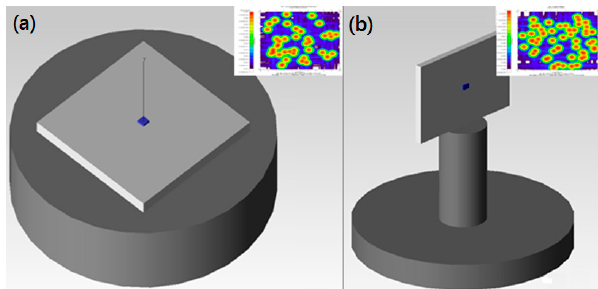
Figure 1. Traditional style of flip chip light ‐ emitting diode (FCLED) on non ‐ transparent submounts ( a ), and proposed transparent mounting of FCLED ( b ). Inset figures show the simulation flux results for the two mounting styles with silicon or glass,